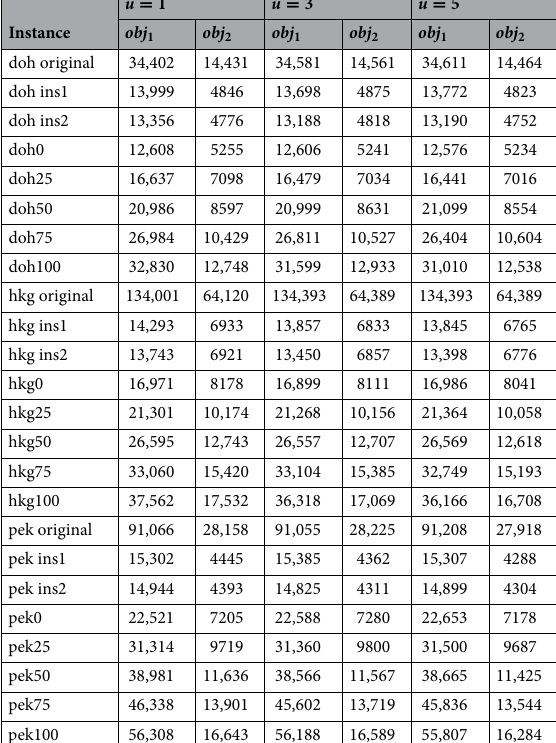
Table 6. Full results for experiments with different values of